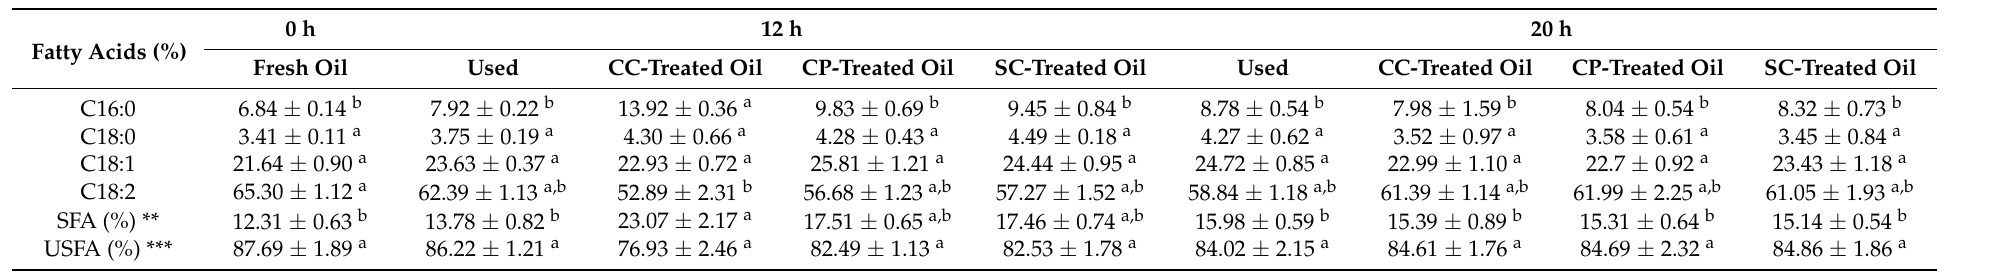
Table 7. Fatty acids profile of fresh, fried (for 12 and 20 h), and adsorbents-treated oils with different lignocellulosic biomasses adsorbents, including corn cob (CC), cornstalk piths (CP), and sugarcane bagasse (SC). Means with different letters ( a , b ) within each row indicate statistically significant differences between the samples after Duncan’s analysis ( p <